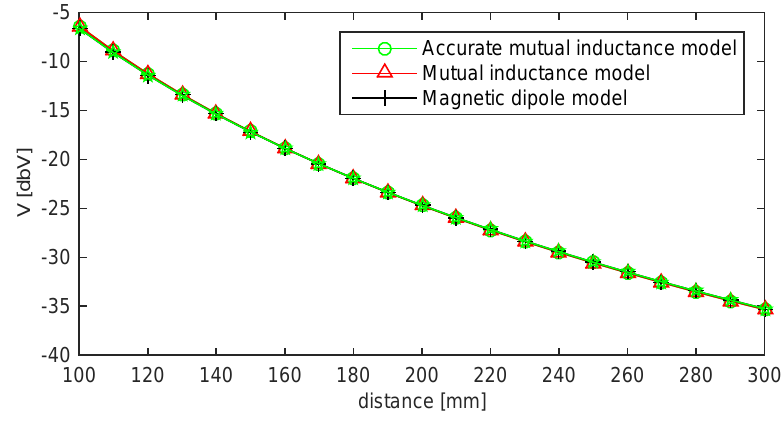
Figure 3. Preliminary calibration performed before the numerical simulation.